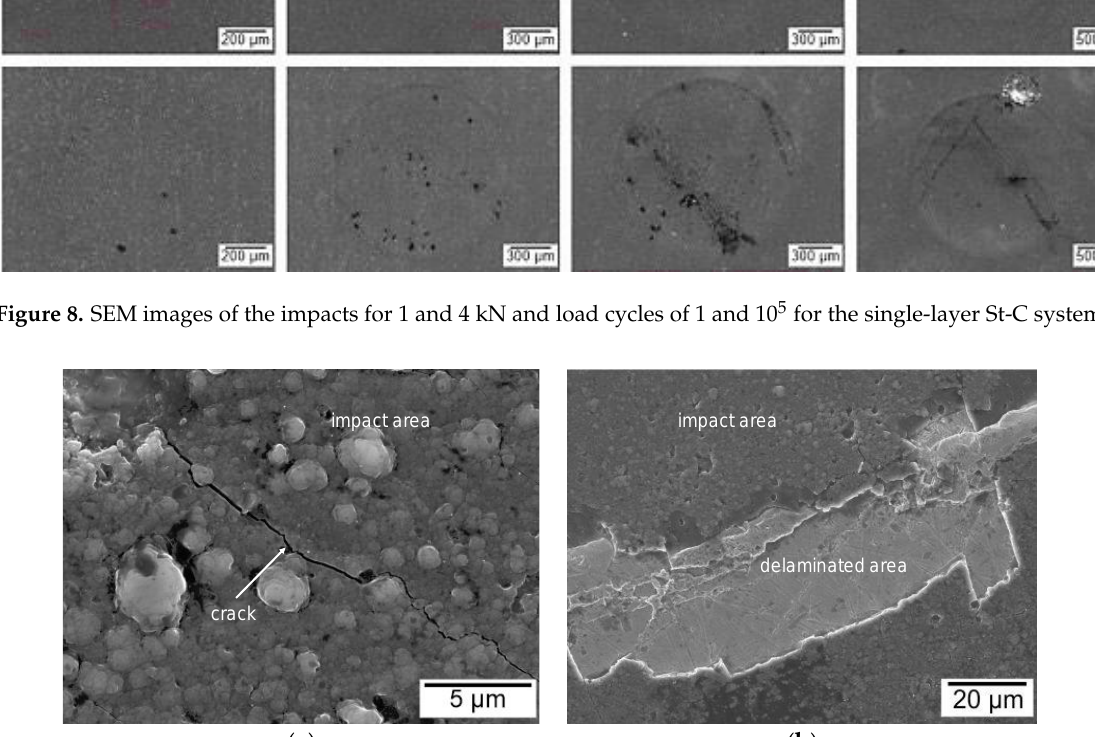
Figure 9. Failure patterns in the outer edge of the impact zone for St-C: ( a ) Impact area and crack for the impact created at 3 kN and 1 load cycle; ( b ) Outer edge of the impact zone with significant crack patterns and coating delamination after being subject to 10 5 cycles at 4 kN.